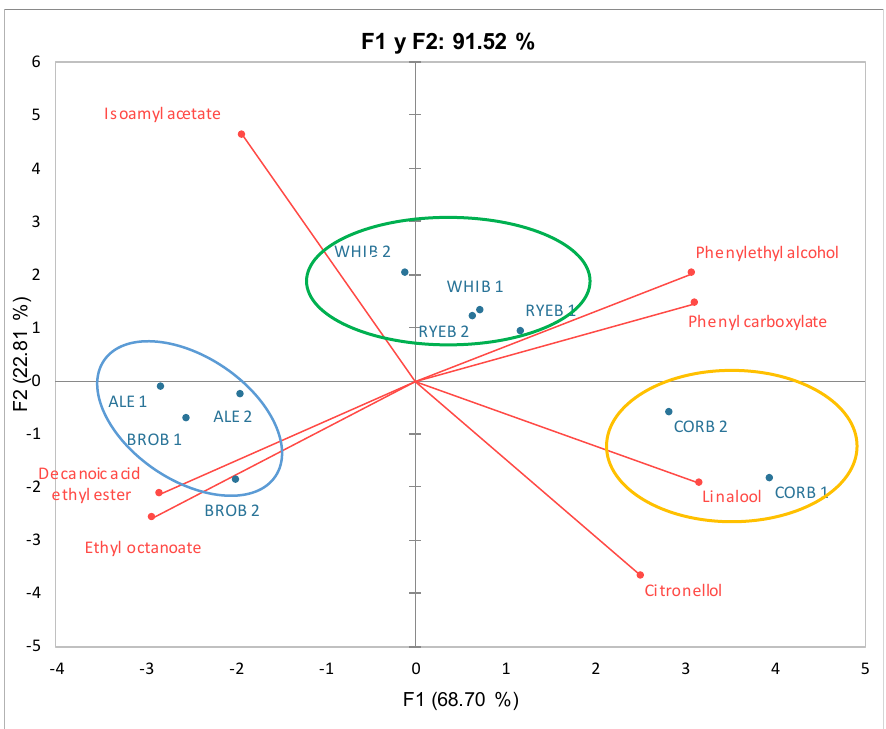
Figure 3. Principal component analysis of volatile compounds in analyzed bread beers. Factor 1 had negative loadings for isoamyl acetate, ethyl octanoate, and decanoic acid ethyl ester, as well as high positive loadings for citronellol, linalool, phenylethyl alcohol, and phenyl carboxylate. Factor 2 had positive loadings for isoamyl acetate, phenylethyl alcohol, and phenyl carboxylate, as well as negative loadings for ethyl octanoate, decanoic acid ethyl ester, citronellol, and